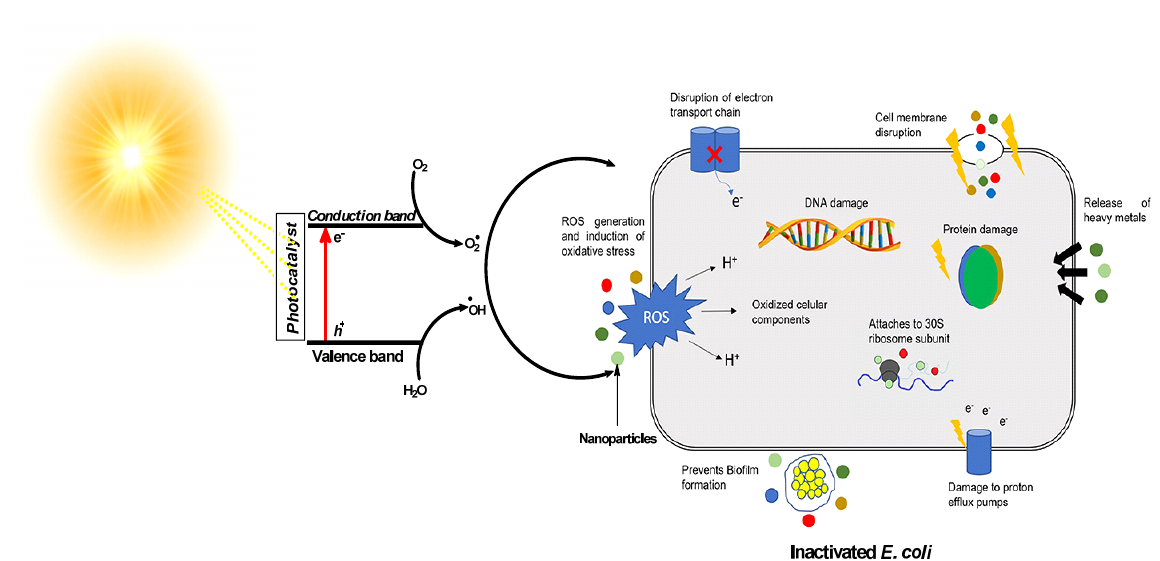
Figure 2. Mechanism of photocatalytic inactivation of E. coli.